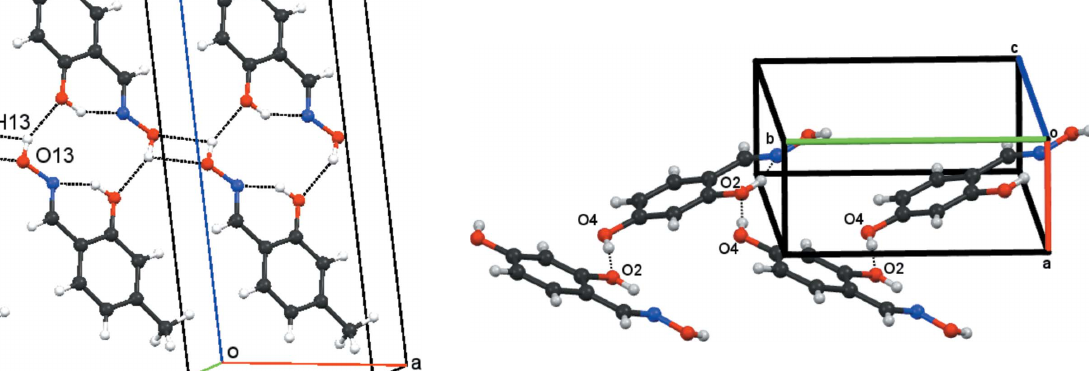
Figure 6 Compound 2 , part of a spiral C 6 chain formed from O4—H4 (cid:3)(cid:3)(cid:3) O2 hydrogen